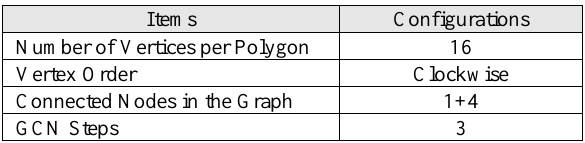
Table 5.3: Configuration of R-PolyGCN Model